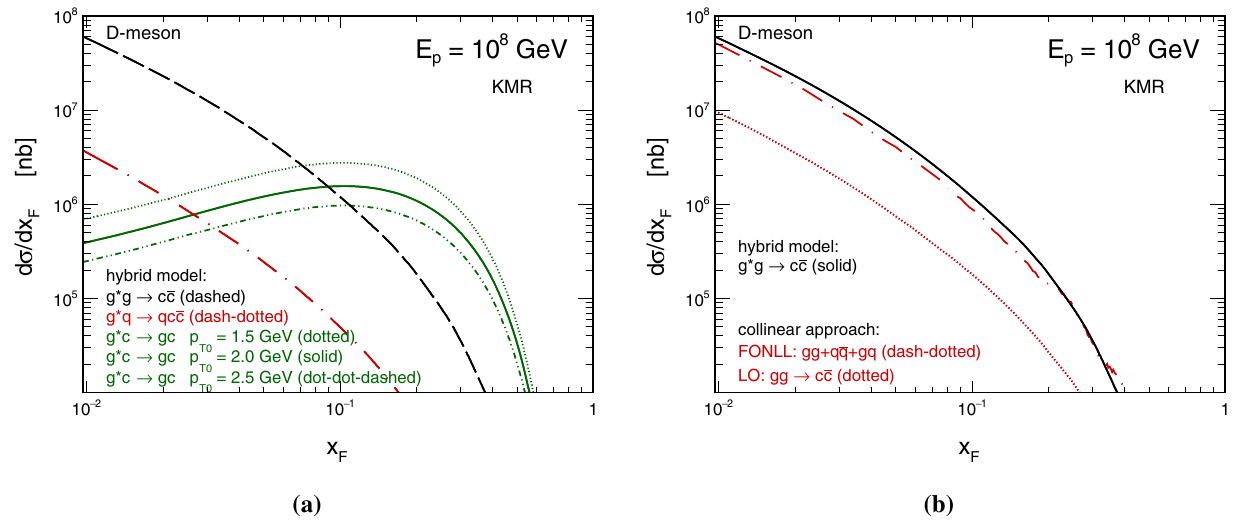
Fig. 4 a Predictions of the hybrid model for the Feynman x F distribution considering the different mechanisms for the charm production; b Comparison between the predictions of the hybrid model for the gg → c ¯ c mechanism and those derived using the FONLL collinear